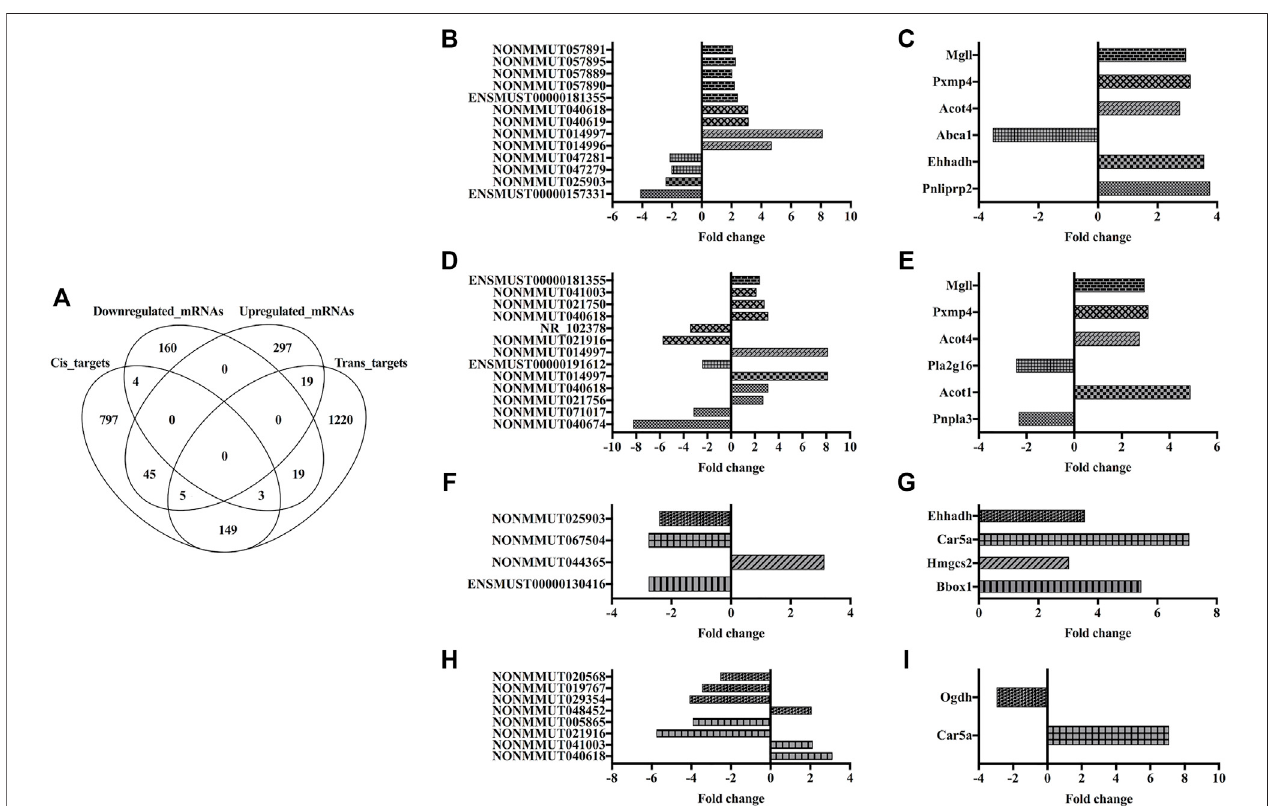
FIGURE 6 | Identi fi cation of lipid and amino acid metabolism-related lncRNAs and downstream mRNAs. (A) Venn diagram showing the overlapping of up- and downregulated mRNAs with trans- and CIS-targets. Histograms of lipid metabolism pathway-related lncRNA – mRNA pairs via CIS- (B,C) or trans- (D,E) regulatory patterns. Histograms of amino acid metabolism pathway-related lncRNA – mRNA pairs via CIS- (F,G) or trans- (H,I) regulatory patterns. The columns with the same fi ll pattern represent lncRNA – mRNA pairs.